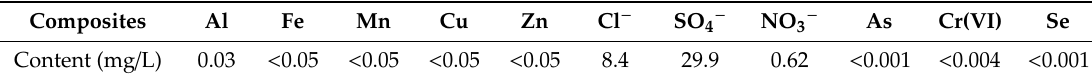
Table 3. Water composite (PH = 7.56).